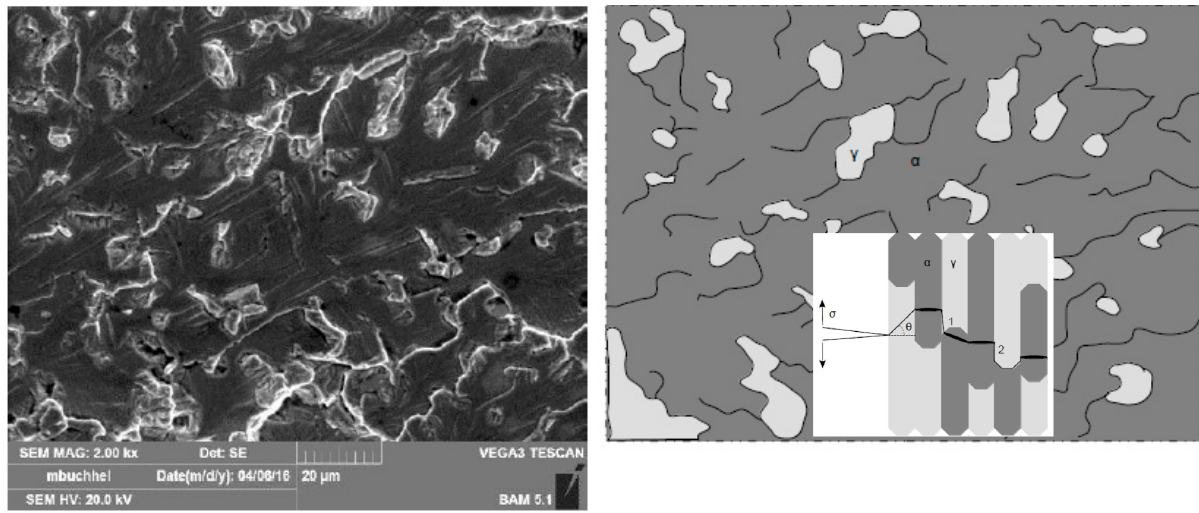
Figure 21. Left: Cross section through the corrosion pit. Etchant: Beraha II. Right: Schematic drawing showing the preferred deterioration of the austenitic phase ( γ ).